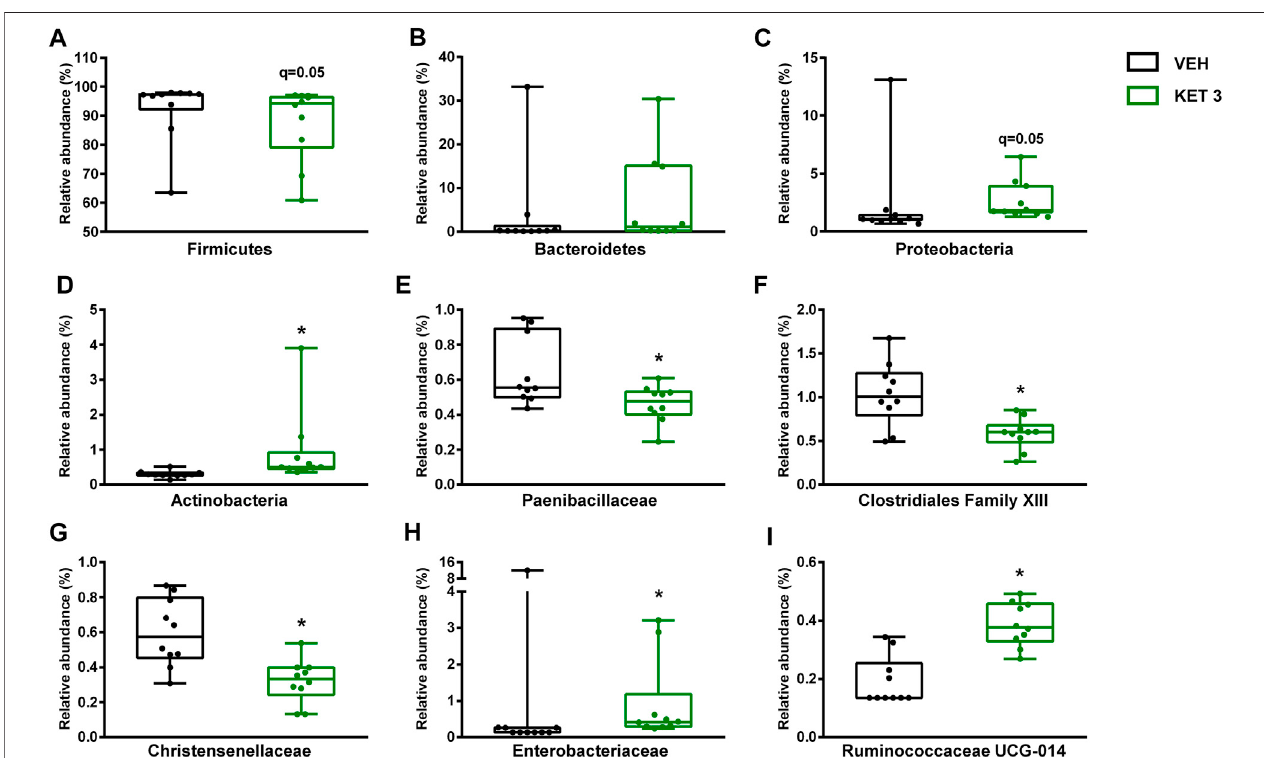
FIGURE4| Theeffectoffour-week vehicle(VEH) orketorolac treatment(KET, 3 mg/kg) onthe small intestinal proportion ofdifferentbacterial phyla (A – D) , families (E – H) and the genus Ruminococcaceae UCG-014 (I) . Box and whisker plots indicate the medians, fi rst and third quartiles, and the minimum and maximum values, the points represent individual samples. The differential abundance tests were performed using ANCOM with Holm-Bonferroni correction for multiple comparison, n (cid:2) 10/ group. *q < 0.05 compared to vehicle-treated group.